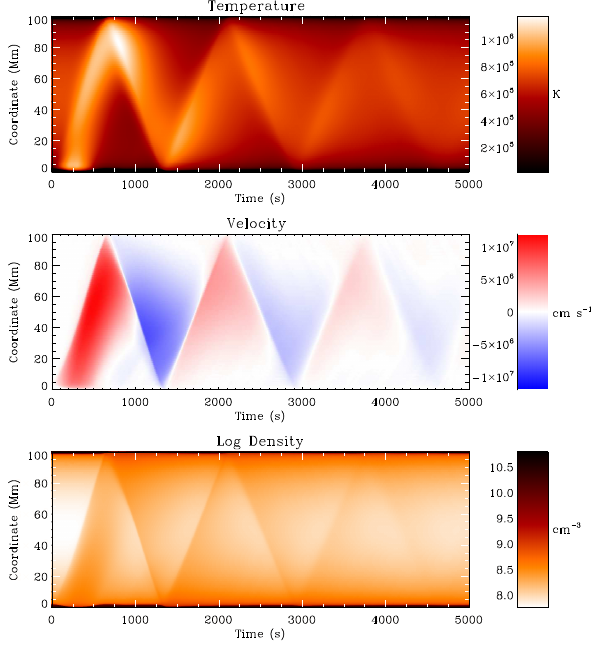
Figure 3. Physical properties of the simulated monolithic loop structure. The plots show the evolution of the temperature (K, top), velocity (cms − 1 , middle), and logarithmic density (cm − 3 , bottom) in time and loop coordinate.